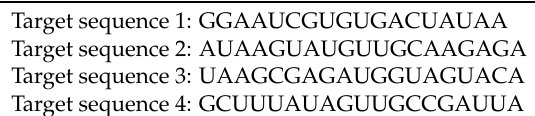
Table 1. SCF -targeted siRNA sequences used in this